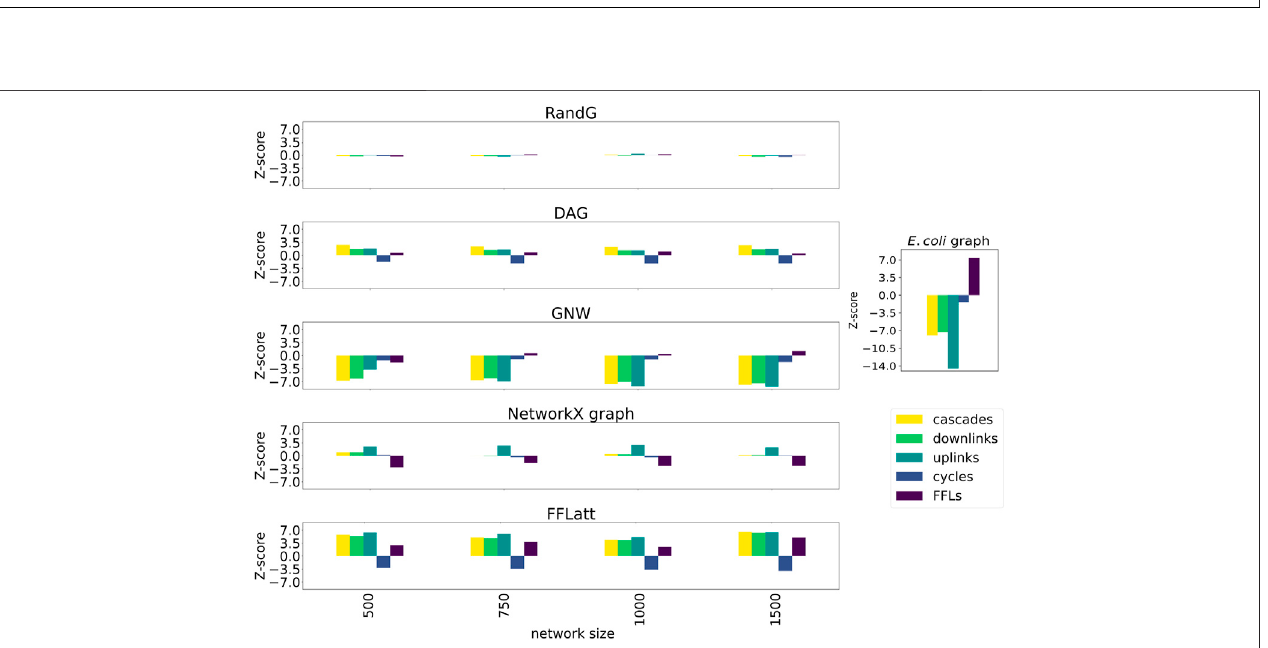
Frontiers in Genetics |